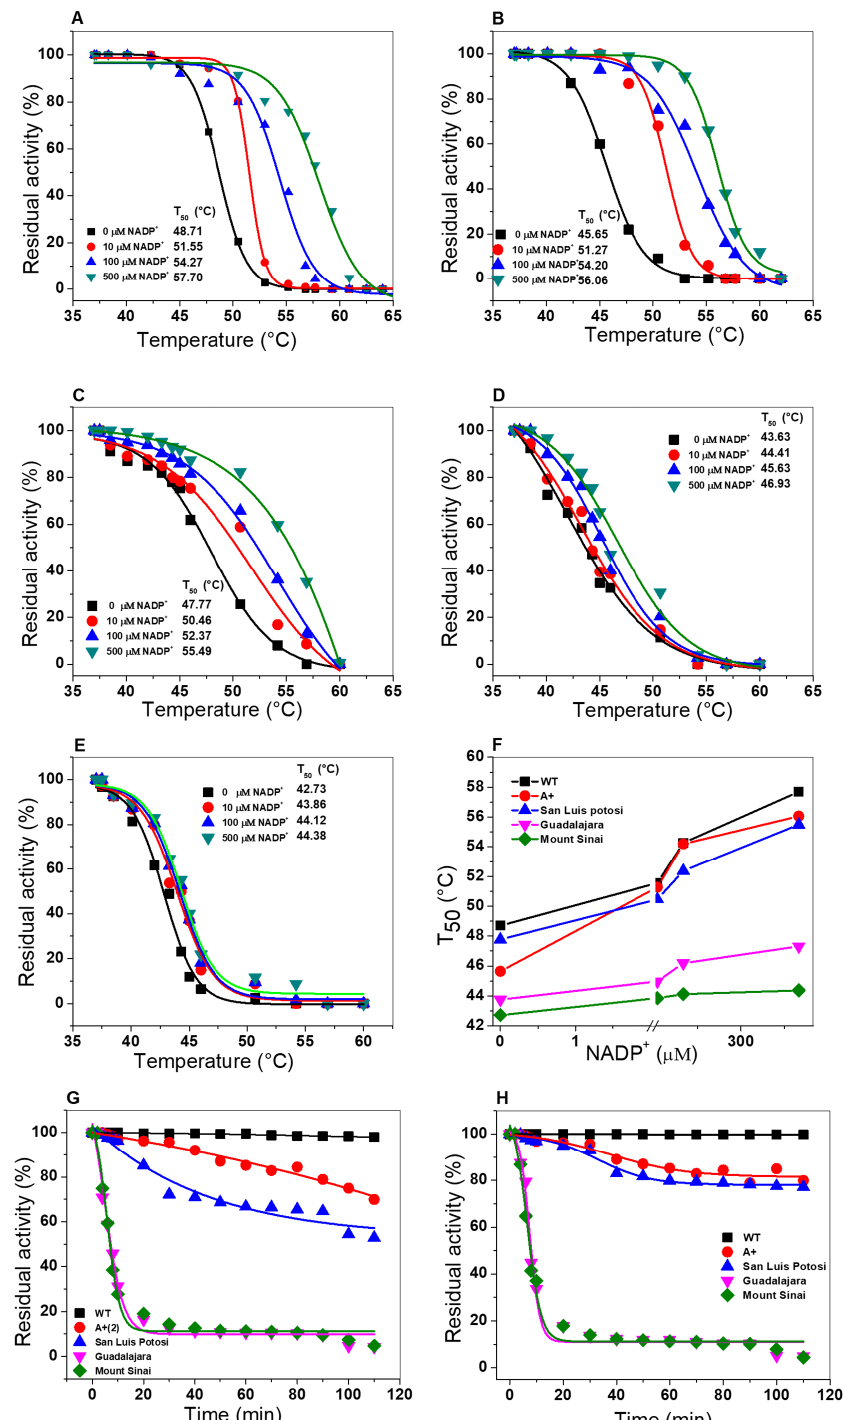
Figure 9. Thermal characterization of three single mutants and a double mutant of G6PD. ( A ) WT G6PD, ( B ) G6PD A + , ( C ) G6DP San Luis Potosi, ( D ) Guadalajara, and ( E ) G6PD Mount Sinai. The recombinant variants were incubated with di ff erent concentrations (0–500 µ M) of NADP + as a stability molecule for 2 h at 37 ◦ C. Residual activity was plotted as percentage activity to calculate T 50 value of each mutant. ( F ) To determine changes in T 50 value of each variant, this was plotted against NADP + concentrations. Thermal inactivation of G6PD variants through time ( G ) without NADP + and ( H ) with 10 µ M of NADP + . Assays were performed in